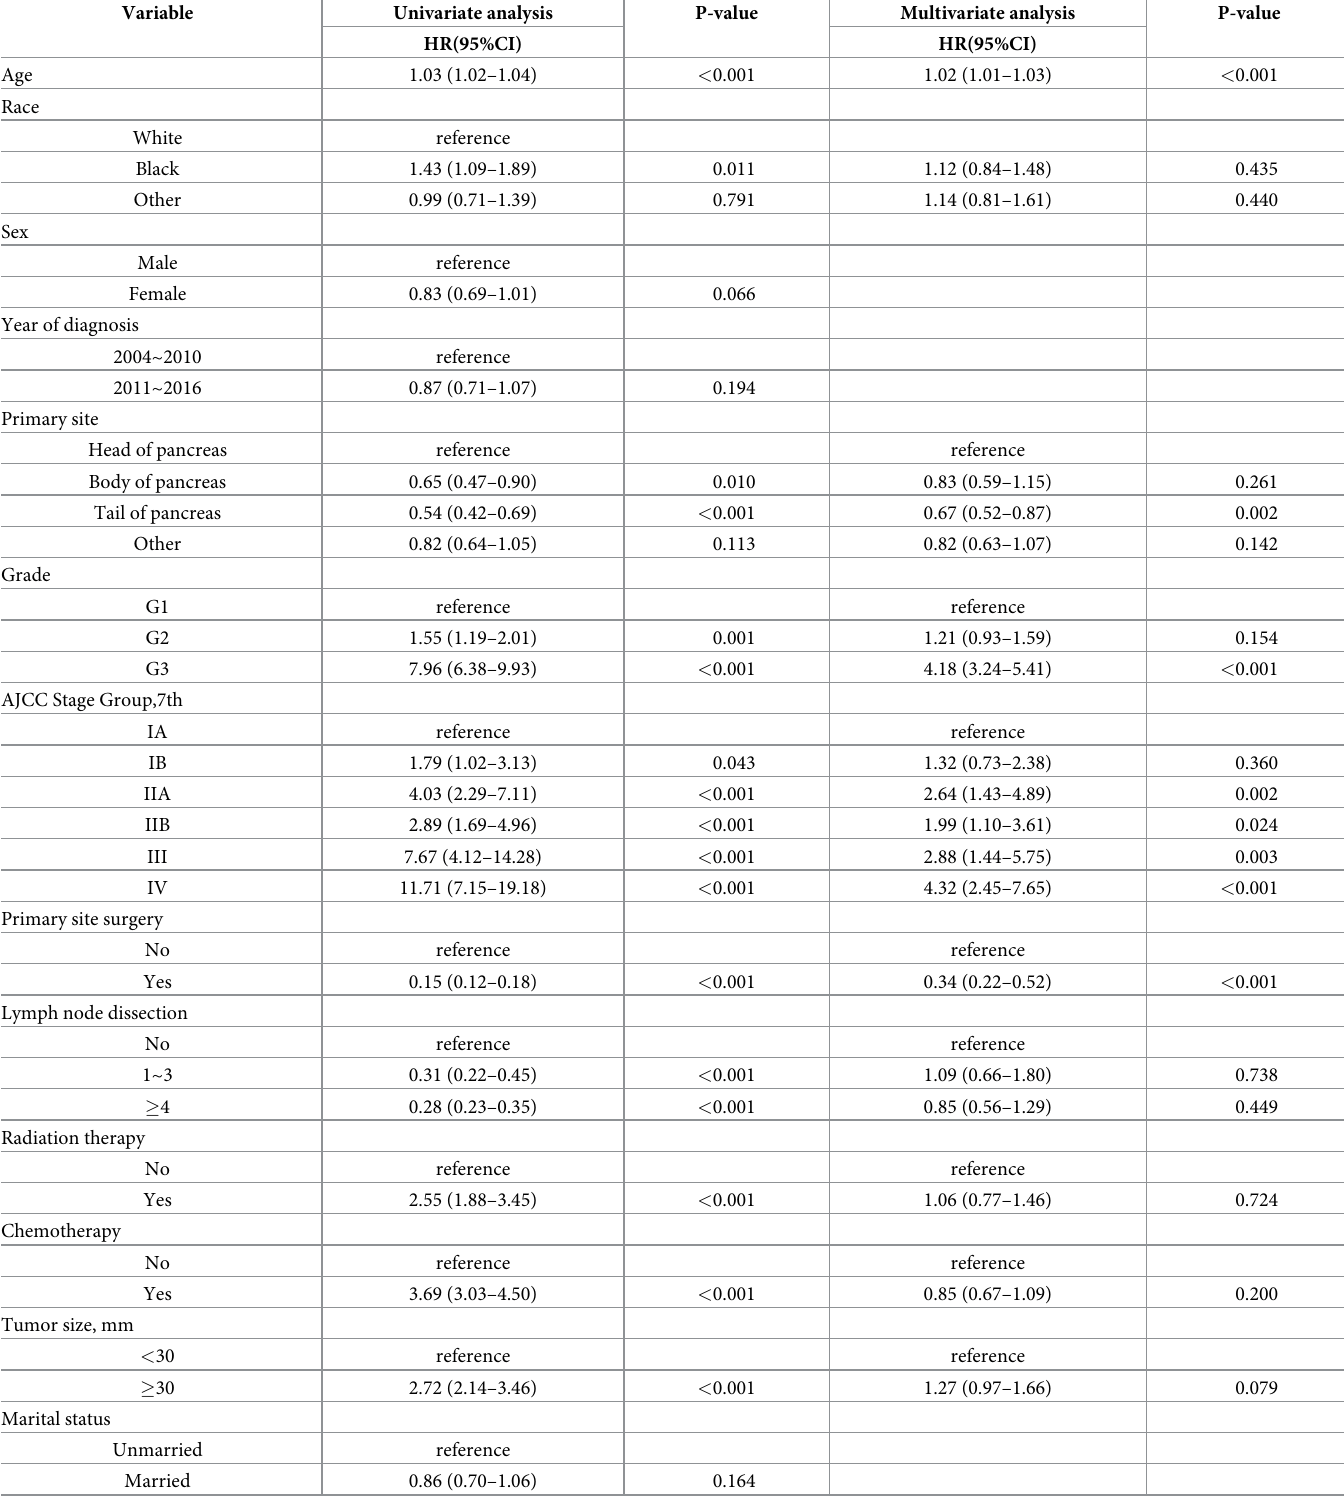
Table 2. Univariate and multivariate Cox regression analysis for OS in NF-pNET patients based on AJCC 7th in training